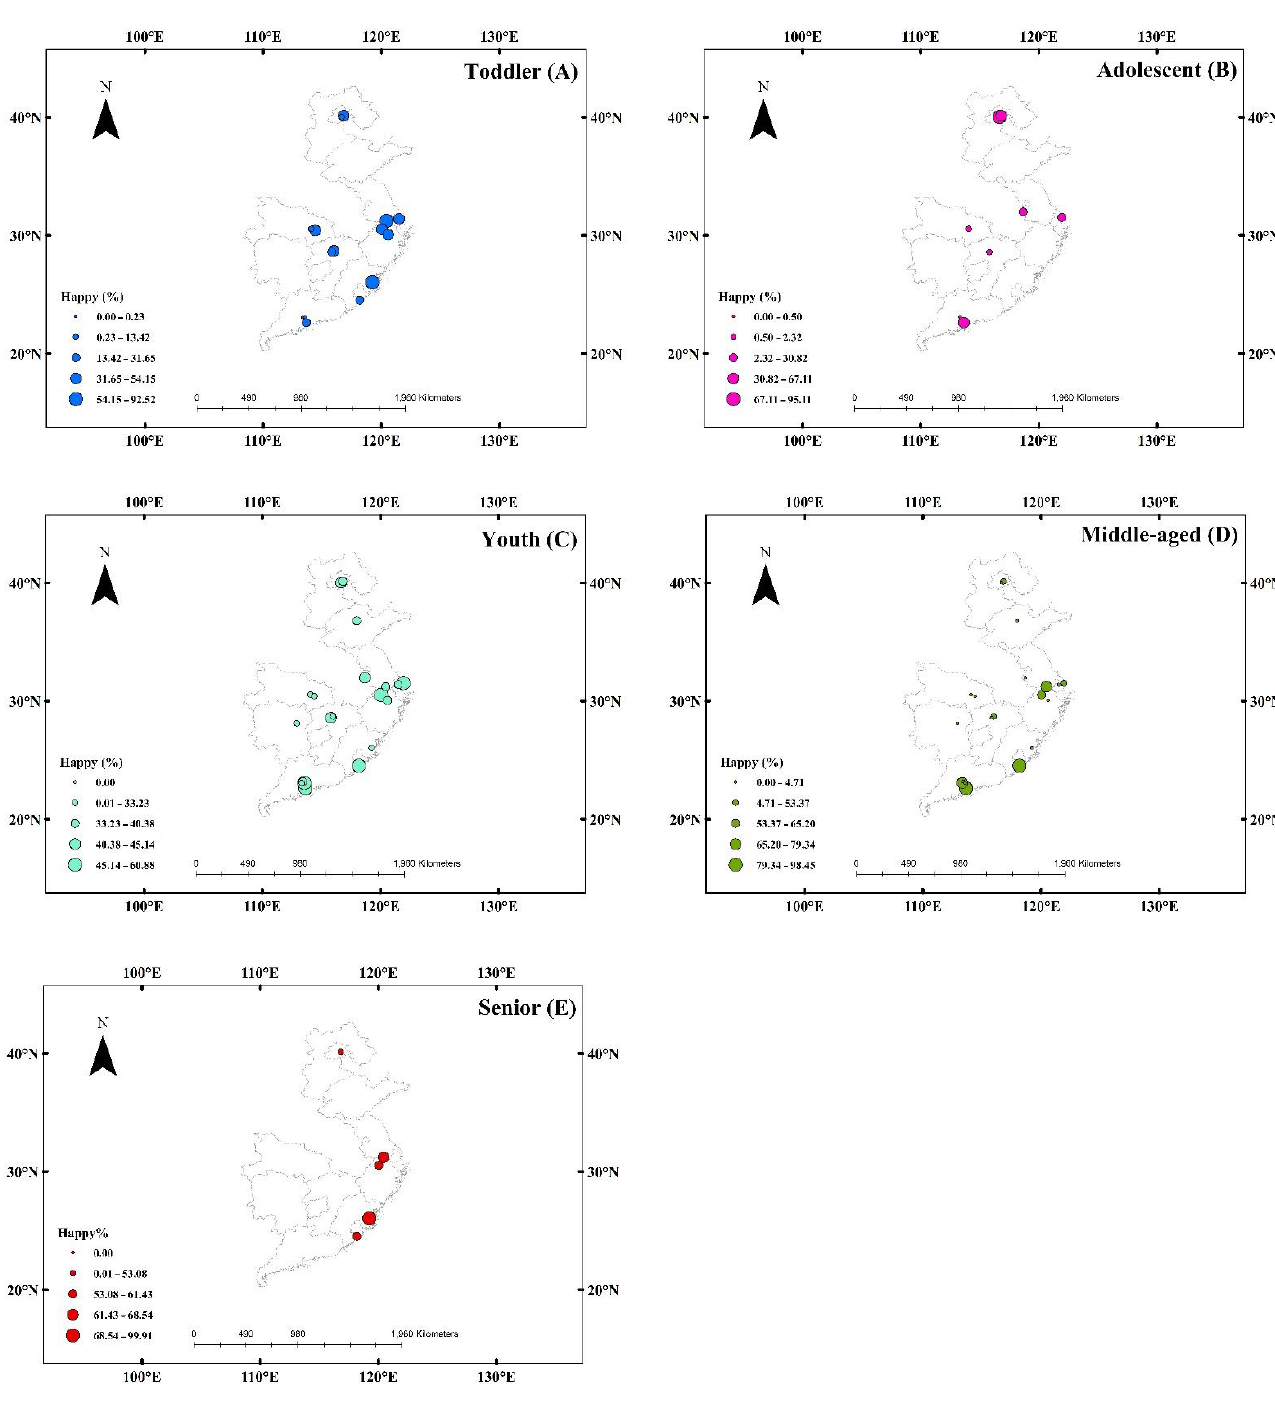
Figure 2. Spatial distribution patterns of happy scores of wetland forest visitors at different ages. Circles present the level of happiness in a positive relationship.